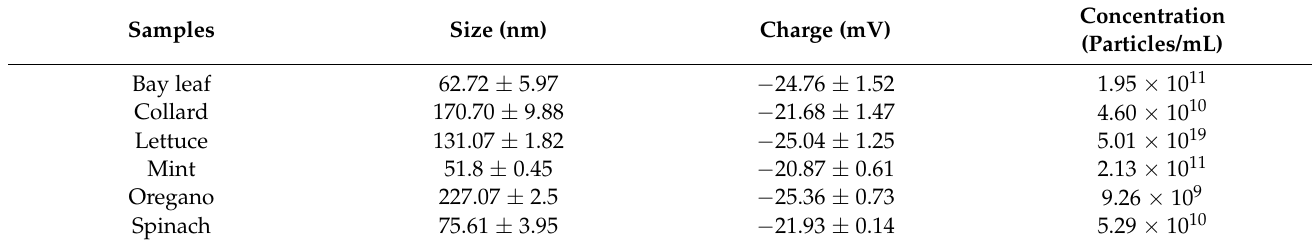
Figure 7. Characterization of bay leaf chlorophyll extract. Dynamic light scattering (DLS) was used to characterize Chl extracts. ( A ) Average particle size for bay leaf extracted Chl was 62.72 nm. X-axis scale was set as log. ( B ) Surface charge was recorded as − 24.76 mV. ( C ) Particle concentration per mL was 1.95 × 10 11 . Data represent the average of three different experiments. Table 1. Physicochemical characterization of six most fluorescent leaves. Particle size, zeta potential, and concentration were measured using dynamic light scattering (DLS) system. Table represents the average of three individual batches.